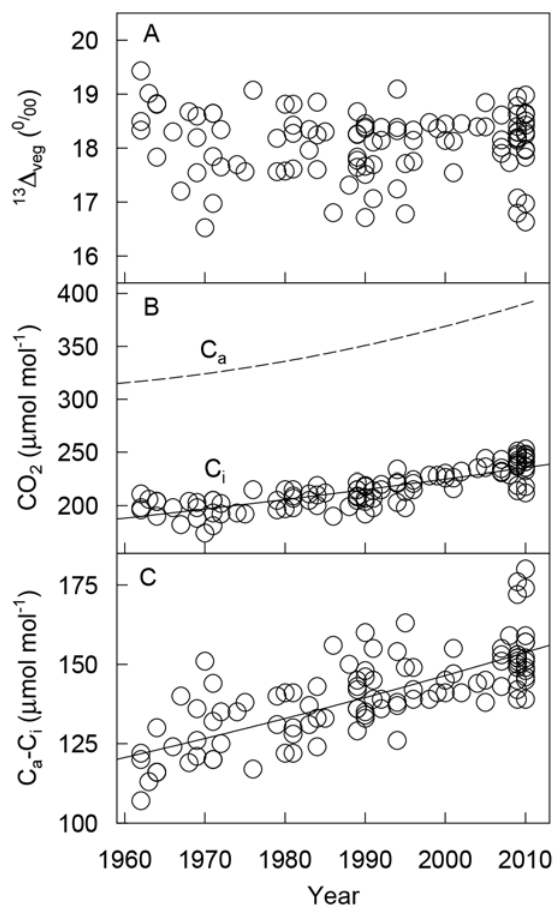
Fig 3. Ecophysiological parameters of Tibetan alpine meadows reconstructed from the δ 13 C time series of wool samples. (A) Carbon isotope discrimination ( 13 Δ veg ); (B) CO 2 concentration in the atmosphere ( C a , dashed line) and in intercellular space ( C i , solid line); (C) the difference between C a and C i ( C a − C i ). The parameter trend lines were calculated using the values derived from δ 13 C of wool samples ( n = 106). The models fitting C i and C a − C i data were y = 0.029e 0.004x and y = 0.009e 0.005x respectively.